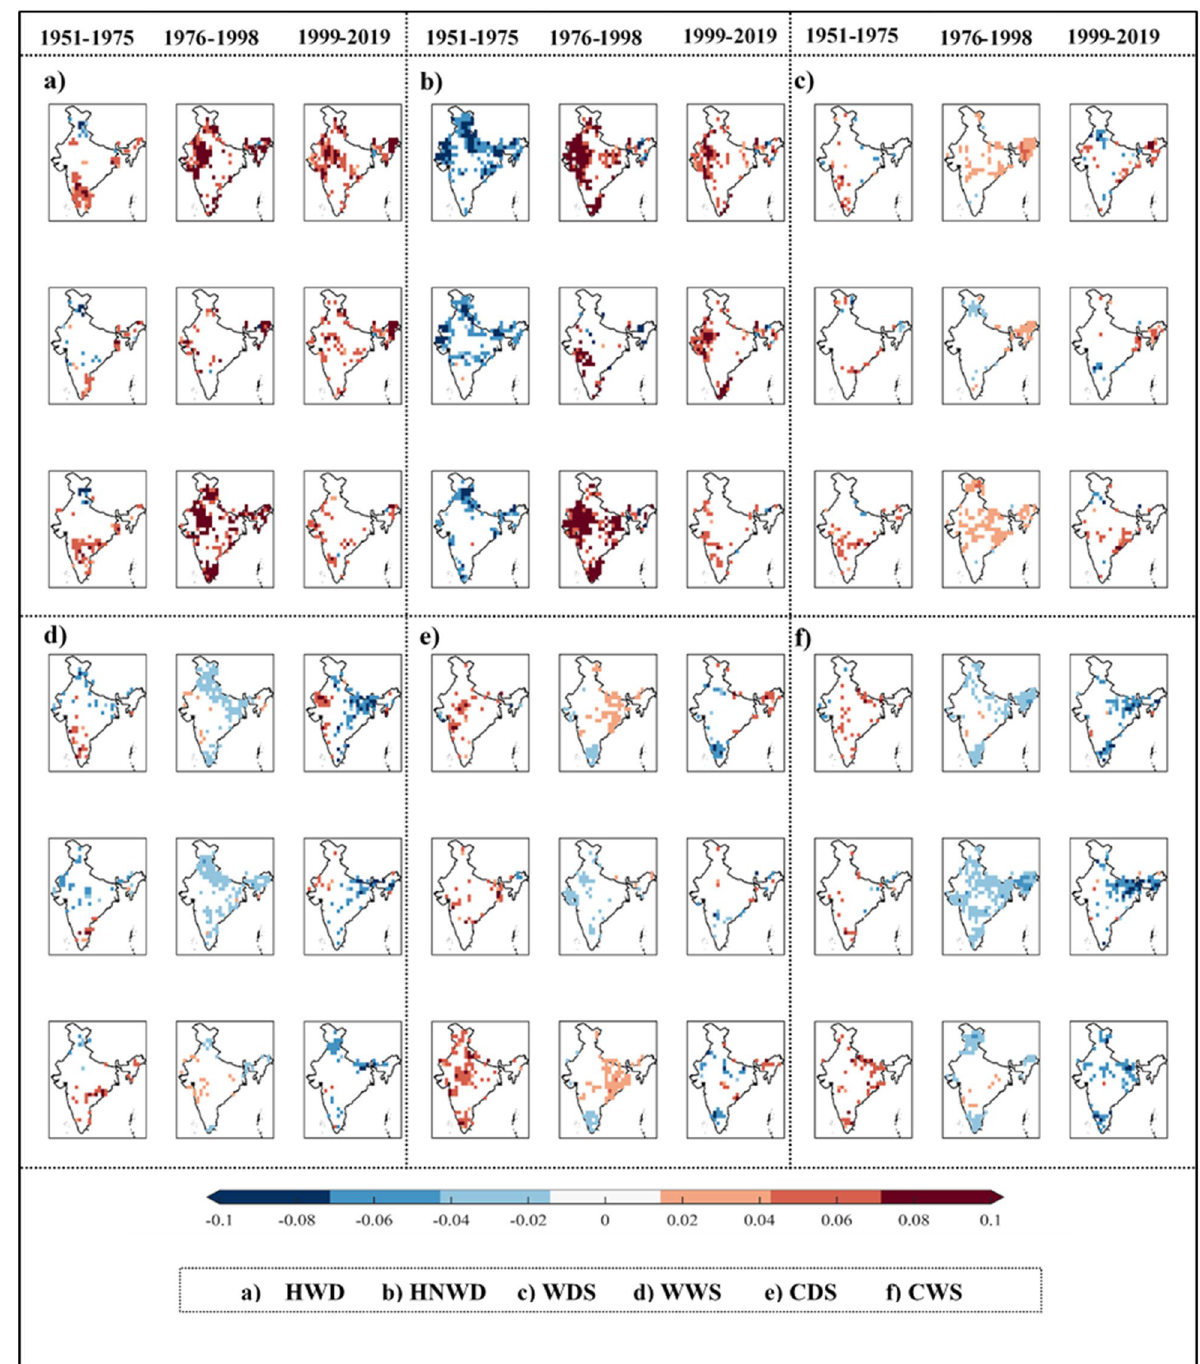
Figure 4. Spatial patterns of significant trends (M–K test at 5% significance) in six Joint Extreme Indices (JEIs) across Indian mainland during pre-climate regime shift period (1951–1975) and two consecutive post-climate regime shift periods consisting of early (1976–1998) and late (1999–2019) post-shift years. Each sub-plot, i.e., ( a – f ) (a particular JEI) shows three set (pre- and post-climate shift periods) results with the data from (top to bottom) entire year, monsoon and non-monsoon period. The figure was produced using MATLAB software (version R2021a, URL: https:// in. mathw orks.